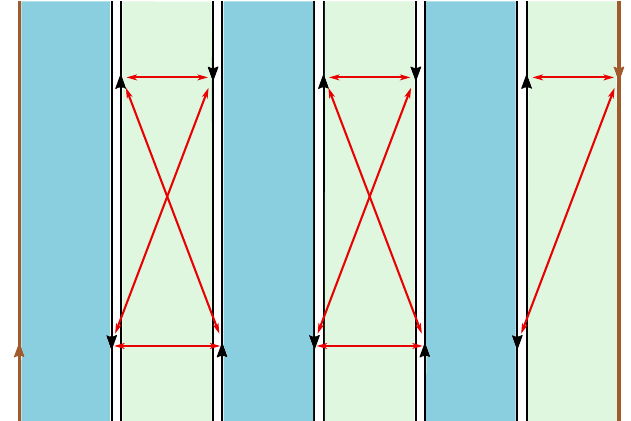
FIG. 9. Illustration of the gapped fermionic spectrum in the coexistence phase of PDW and uniform pairing with a Chern number C ¼ 1